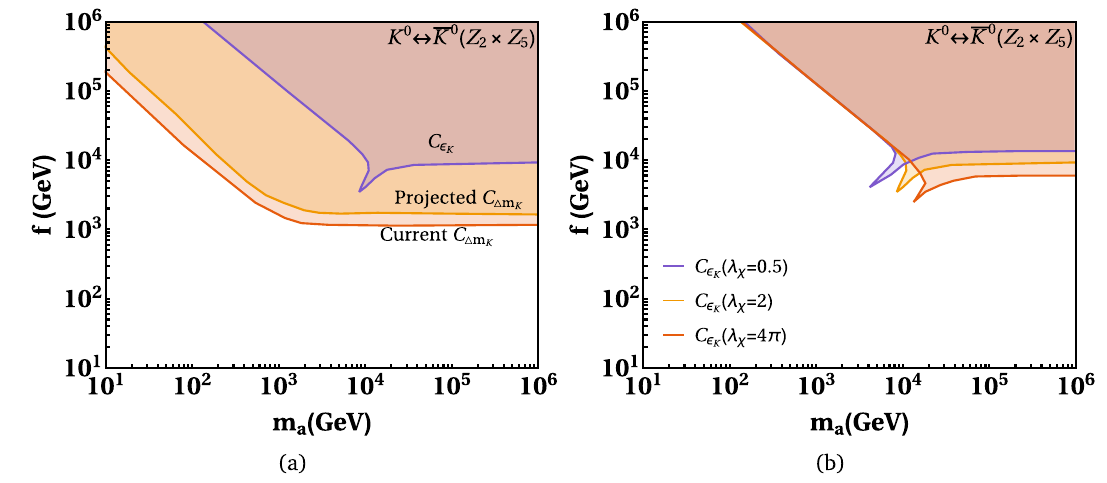
Fig. 1 The allowed parameter space by flavour observables C (cid:7) C (cid:15) m in the m a − f plane for the minimal ( Z 2 × Z 5 ) flavour symmetry. K On the left panel in a , the allowed bounds for λ χ = 2 with current limits for C (cid:15) m and C (cid:7) areshownbyredandvioletboundaries,respectively. K K